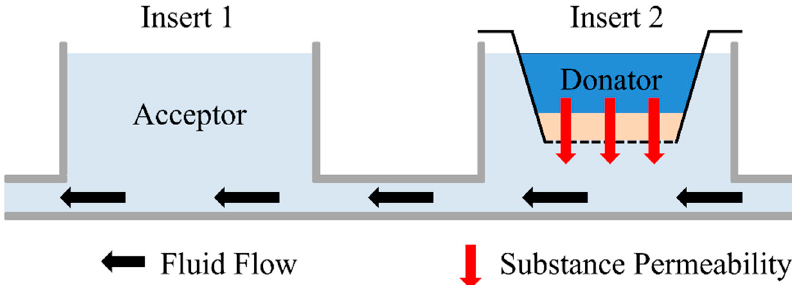
Figure 4. Schematic side view of the 2OC. The acceptor, where the samples are taken, is located at Insert 1. The 96-well CCI system with ftSE is positioned on Insert 2. The donator is the investigated substance on the ftSE. Black arrows indicate the direction of the fluid flow, and the red arrows the permeation.